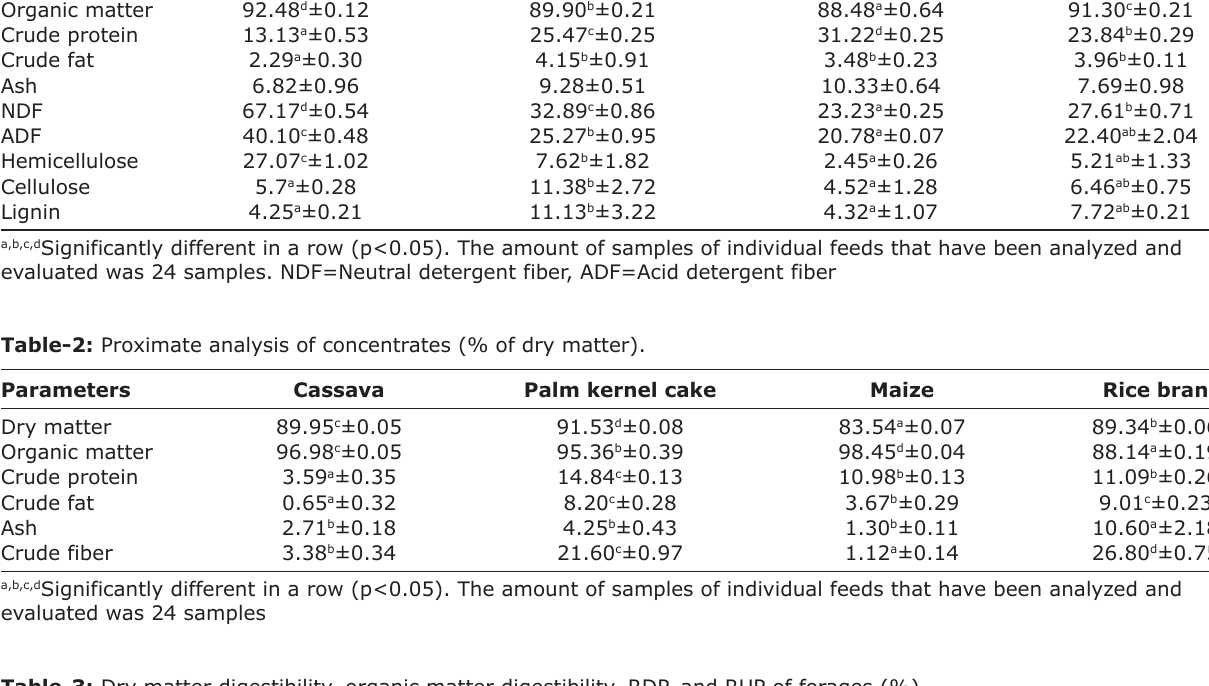
Table-3: Dry matter digestibility, organic matter digestibility, RDP, and RUP of forages (%). Parameters